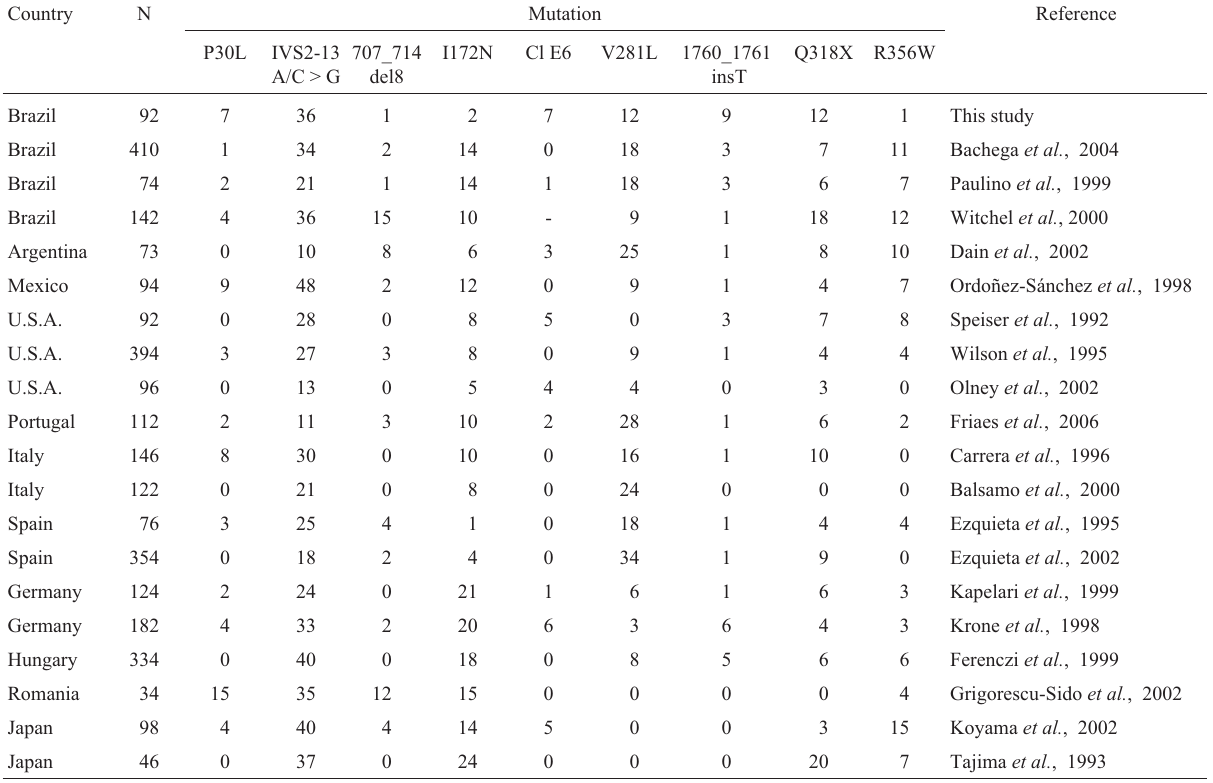
Table 2 - Frequency (%) of the nine most common mutations found worldwide and in Brazilian patients from the Amazon region with classical and nonclassical forms of 21-hydroxylase deficiency. Country N